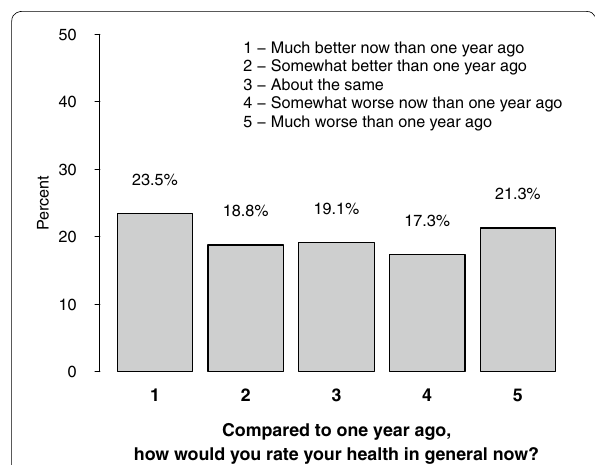
Table 3 Components of the Medical Outcome Study SF-36 questionnaire for critically ill patients with haematological malignancies (HMs) and septic shock patients without HM